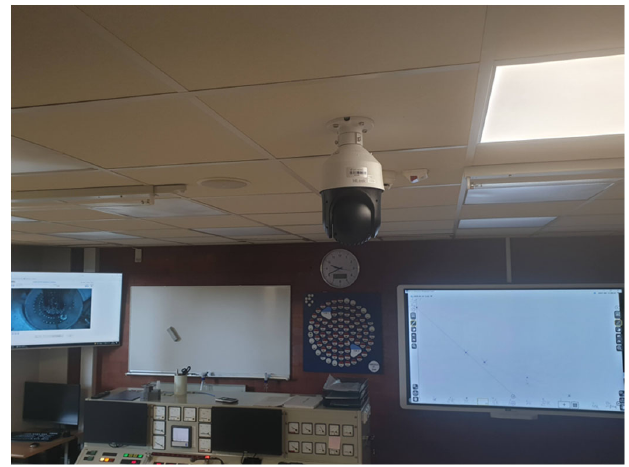
Figure 6 The dome camera is mounted on the ceiling and positioned so it can see the reactor control panel, nuclear instrumentation readings, and the lecturer in front of the shared whiteboard.